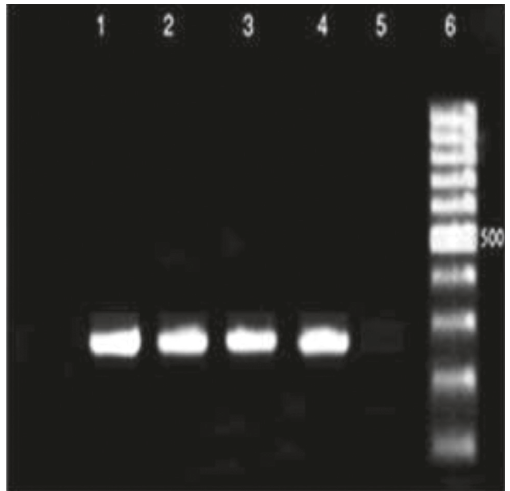
Figure 7: PCR product electrophoresis of 270bp toxA gene and 875bp phzM (from left, lanes 1–3: positive samples of 875bp phzM gene, lanes 4 and 5: positive sample of 270bp toxA gene, lane 6: negative controls, and lane 6: marker 100bp).